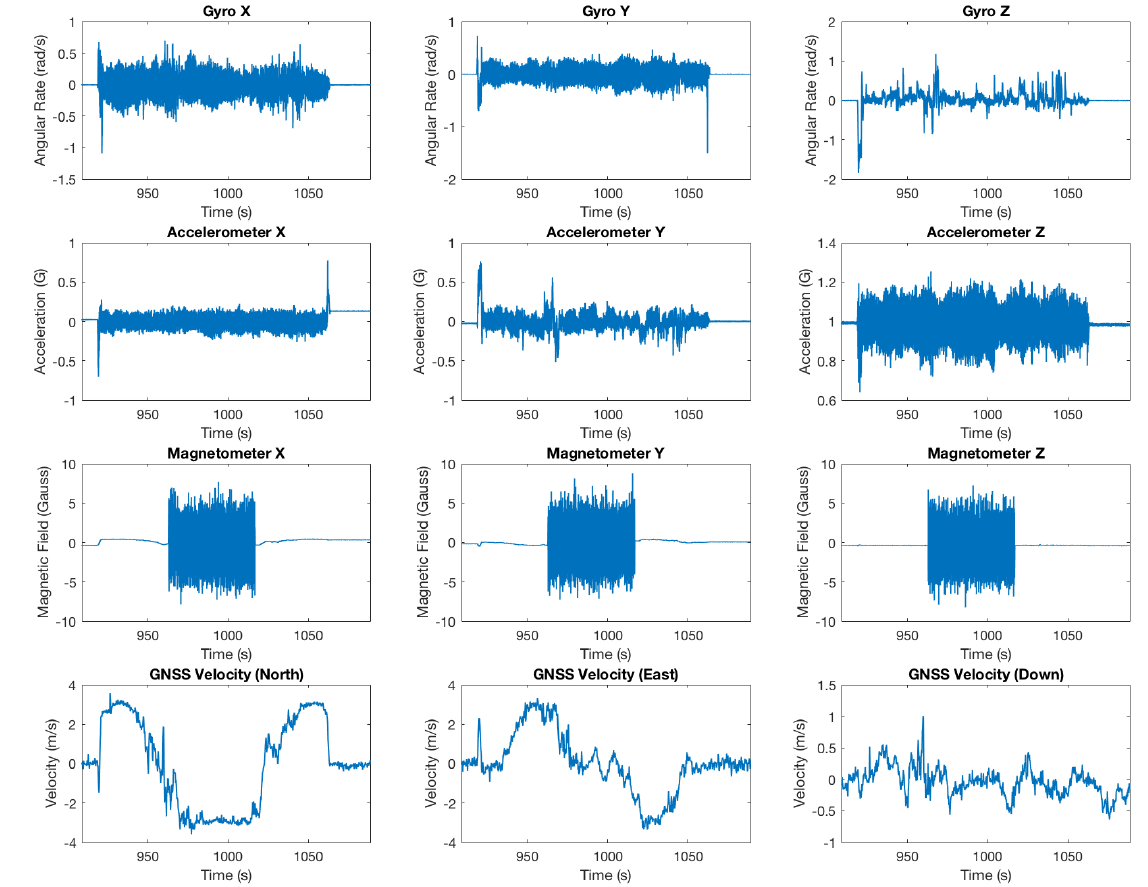
Figure 7. Raw sensor measurements from the memory